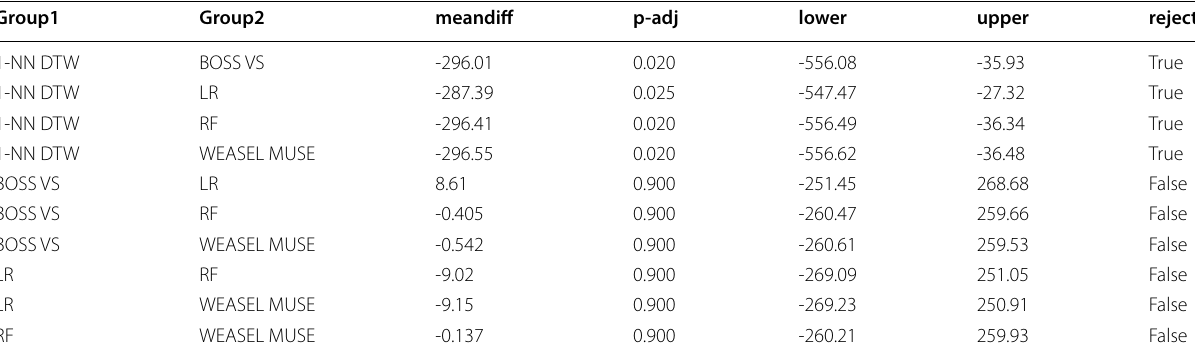
Table 9 Multiple Comparison of Means of run time ‑ Tukey HSD Group1